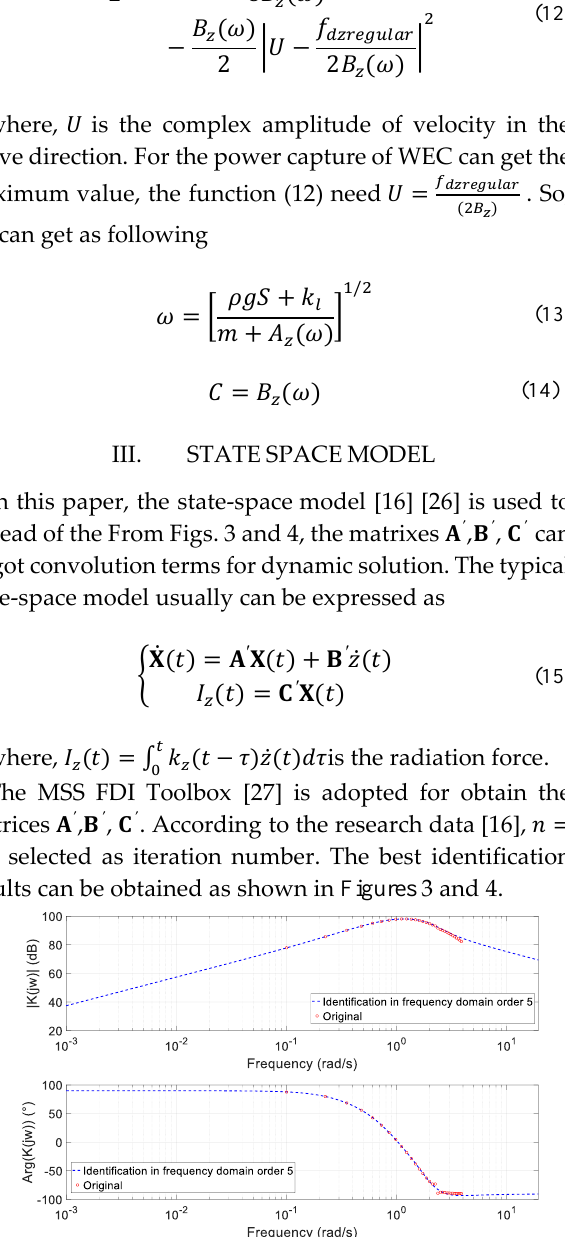
Fig. 3. The best identification results of the retardation